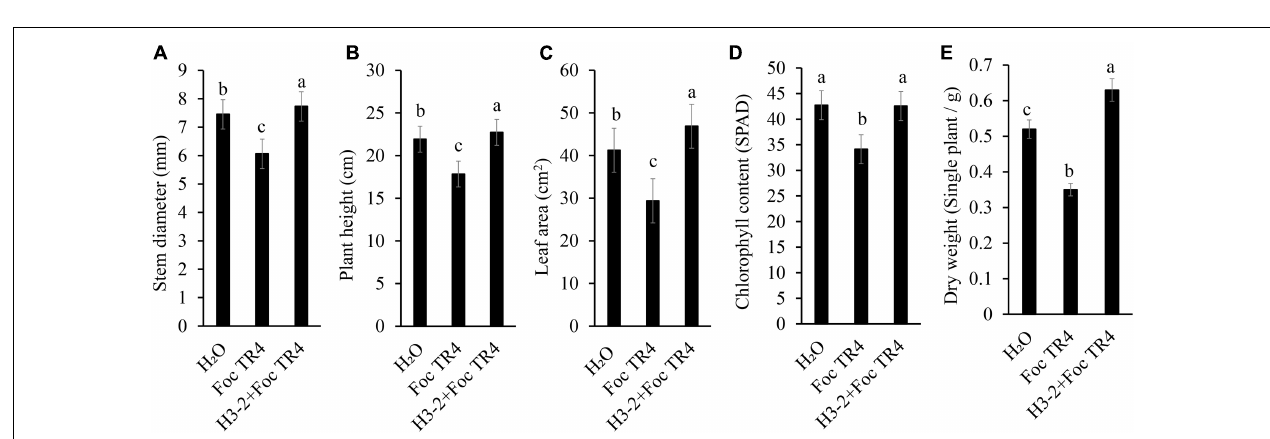
FIGURE 8 | Effects of the strain H3-2 fermentation broth on the growth of banana seedlings and resistance to Foc TR4 in the control (Foc TR4) and the two treatments. (A) Chlorotic leaves and growth of banana seedlings were detected 35 days after strain H3-2 treatment. Bars = 10 cm. (B) Infection characteristics of Foc TR4 on corms and roots of banana seedlings. The arrows indicate infection sites of Foc TR4. Bars = 1 cm. (C) Statistical analysis of disease indexes of banana seedlings 35 days after inoculation with Foc TR4. All experiments were repeated in triplicates. Different lowercase letters indicate a significant difference at the level of p < 0.05.